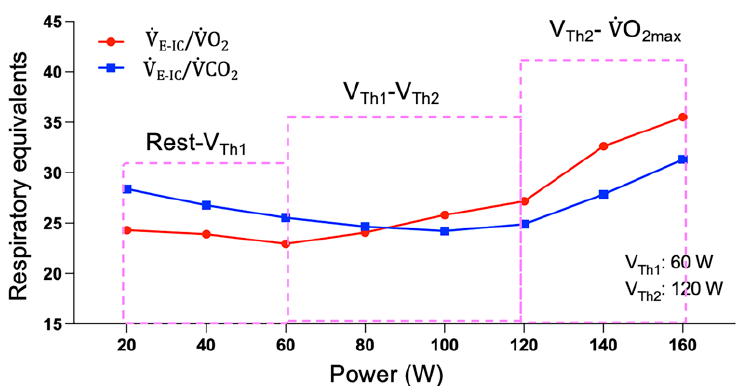
Figure 3. An example of determining the three levels of intensity during the maximal graded test.